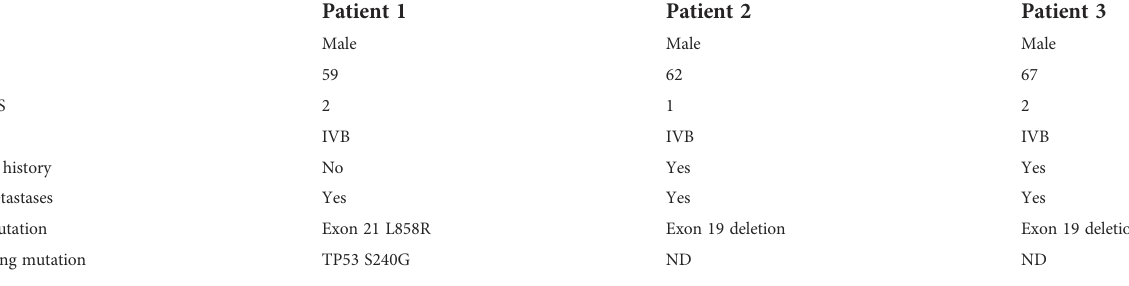
TABLE 1 Baseline demographic and clinical/molecular characteristics of